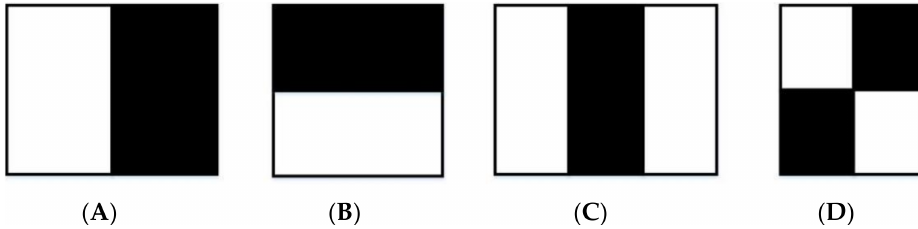
Figure 5. Four basic Haar-like feature structures. ( A ) Edge feature of left and right, ( B ) Edge feature of up and down, ( C ) Line feature, ( D ) Center-surround